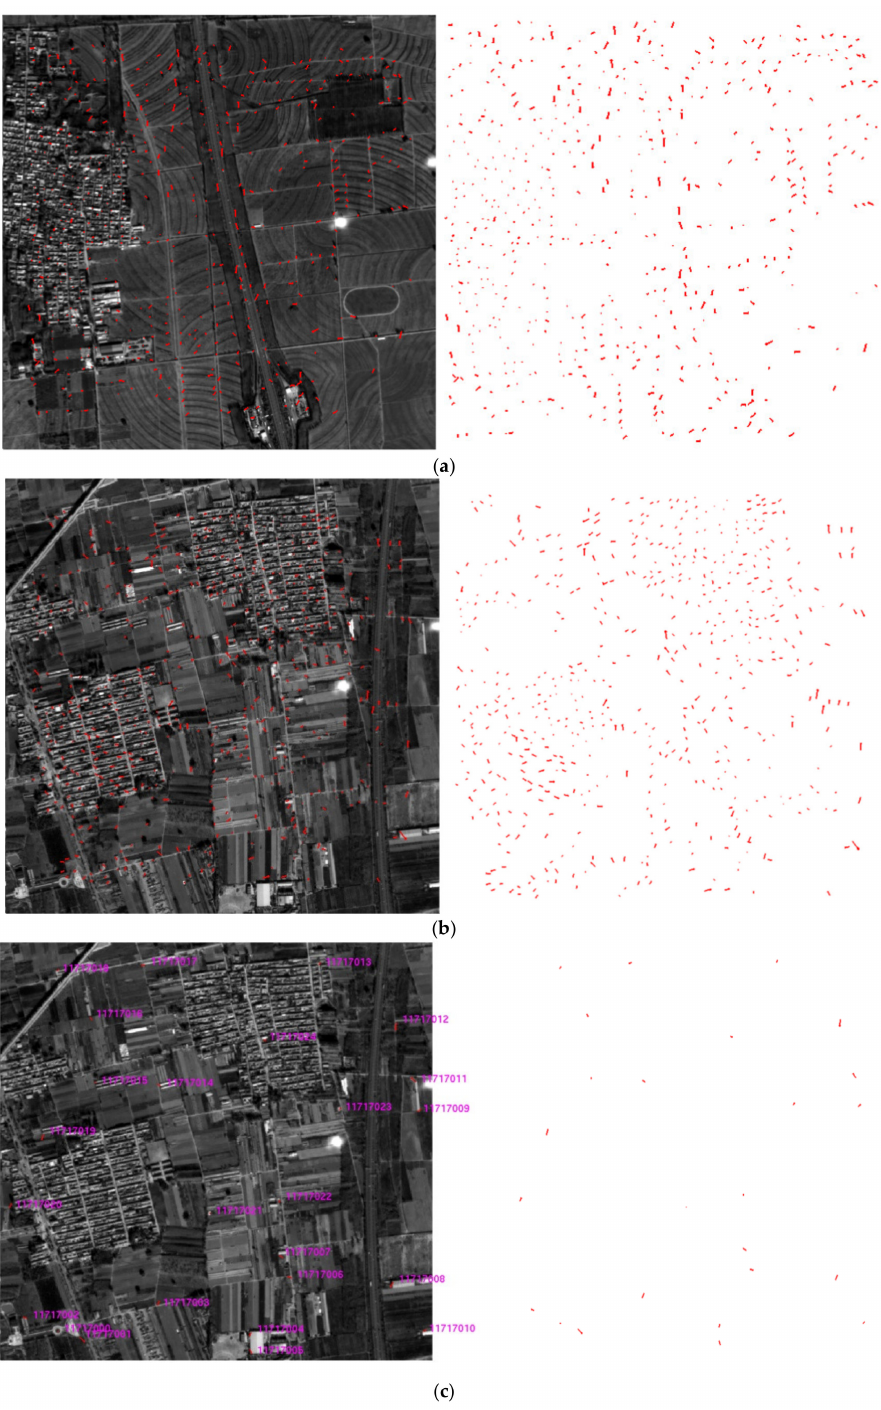
Figure 11. Final matches and residual distributions (10 × magnification). ( a ) 580 points left after mismatch removal on image 723 (RMSE: 0.36 pixel). ( b ) 581 points left after mismatch removal on image 717 (RMSE: 0.39 pixel). ( c ) Residual distribution of 25 manually collected control points on image 717 (RMSE: 0.55